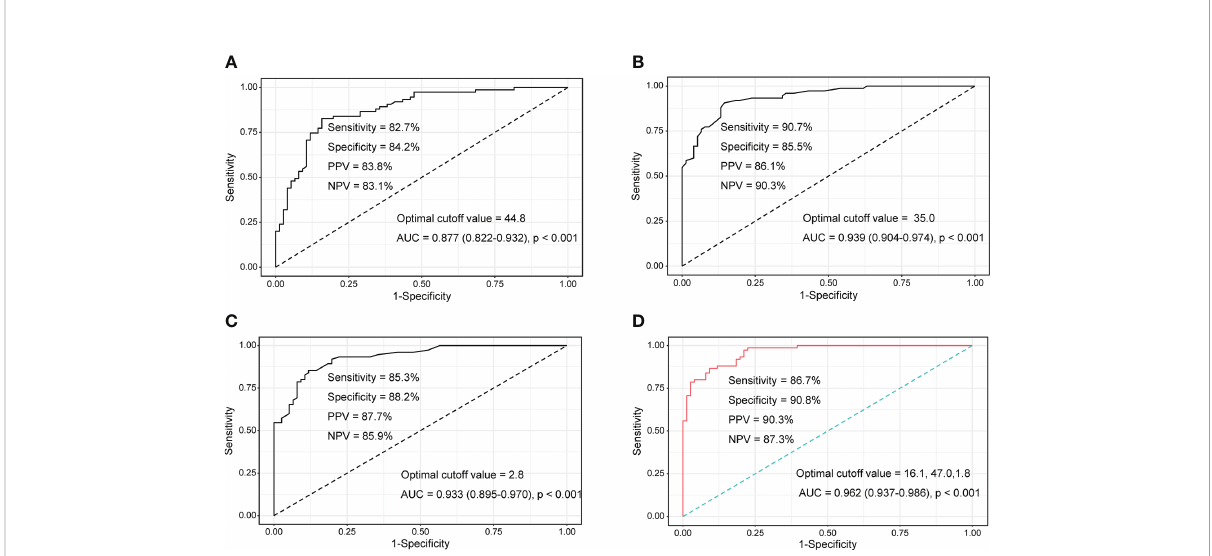
FIGURE 3 ROC curves of tumour M2-PK, ESR, and CRP to determine moderate/high disease activity and remission/low disease activity. Area under the ROC curve for (A) tumour M2-PK, (B) ESR, (C) CRP, and (D) integration of tumour M2-PK, ESR, and CRP for determining optimal cut-off values in discriminating moderate/high RA activity (DAS28-ESR ≥ 3.2) and remission/low disease activity (DAS28-ESR < 3.2). ROC: Receiver operating characteristic; Tumour M2-PK, dimeric form of pyruvate kinase M2; ESR, erythrocyte sedimentation rate; CRP, C-reactive protein; RA, rheumatoid arthritis.